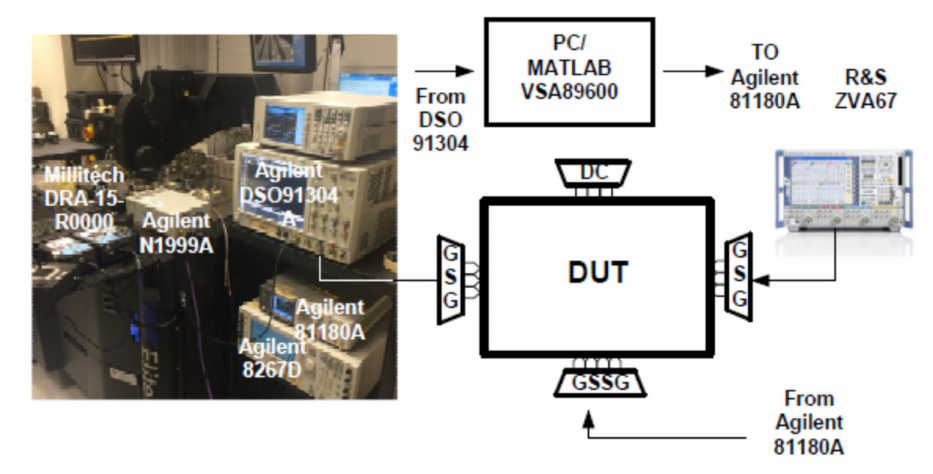
Figure 5. The measurement setup of ILTX.